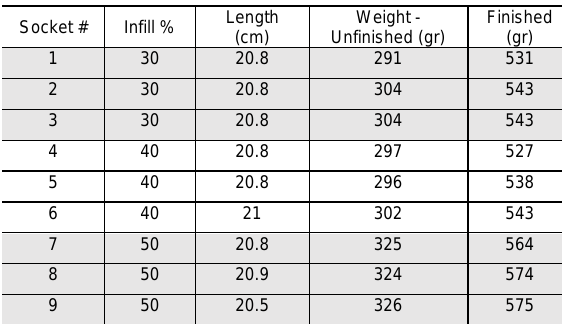
Figure 1. 3D-Printed TT Socket Table 1. Characteristics of the 3D-Printed